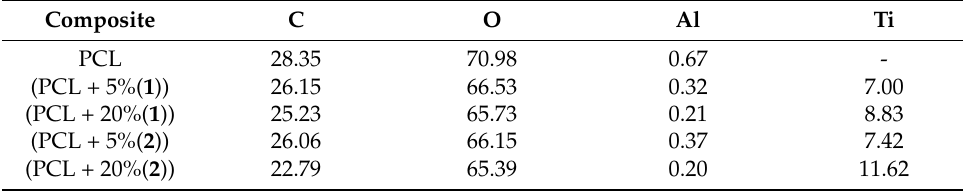
Table 1. SEM EDX quantitative data; mean value of mass percent